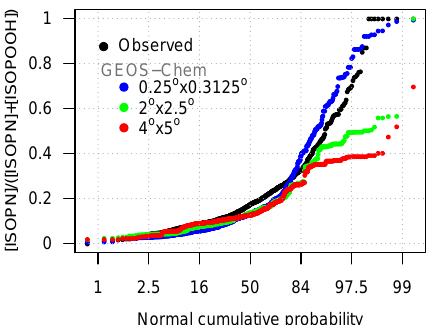
Figure 3. Cumulative probability distribution functions (CDFs) of ratio measuring the relative importance of the [ ISOPN ] [ ISOPN ]+[ ISOPOOH ] the high-NO x pathway vs. low-NO x pathways for isoprene oxida- tion. High values of the ratio indicate a dominant high-NO x path- way. Mixed layer observations from the SEAC 4 RS aircraft over the Southeast US are compared to GEOS-Chem output along the flight tracks at different resolutions. The x axis is a normal probability scale such that a normal distribution would plot on a straight